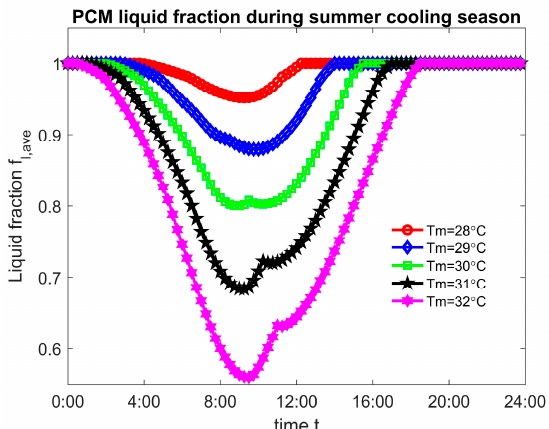
Figure 7. The PCM layer average liquid fraction during the summer cooling season at different melting temperatures.